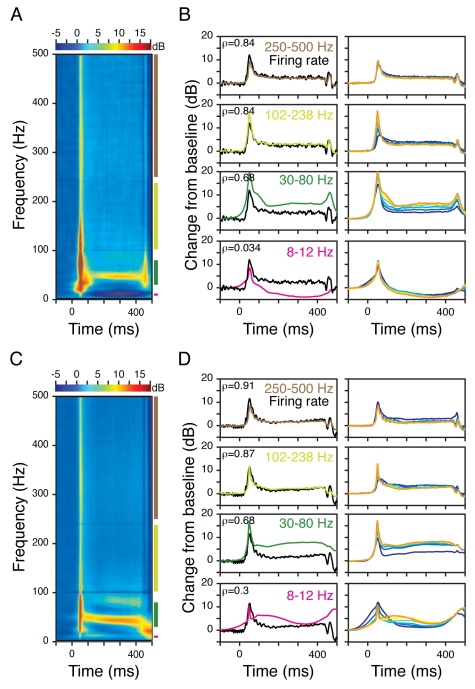
Correlations between the time-courses of firing rate and LFP power in
different frequency bands.(A) The mean time-frequency energy difference plot (in dB) of 15 sites
from Monkey 1, when the largest stimulus is presented. Same as the right
panel of Figure 1E,
except that the displayed frequency range is up to 500 Hz. The vertical
colored lines in the right mark the four frequency bands used for
analysis—alpha (8–12 Hz; magenta), gamma (30–80 Hz;
dark green), high-gamma (102–238 Hz, excluding 118–122 Hz;
light green), and 250–500 Hz (brown). (B) Panels in the left
column show the relative change in LFP power in the four frequency bands
(colored traces) for the largest stimulus, along with the relative
change in firing rate (black trace, same for all panels). The Spearman
rank correlation between the two traces is denoted in the upper-left
corner. Panels in the right show the relative change in LFP power for
different stimulus size (same color code as Figures 1 and 2, the orange trace is the same as
the colored trace in the left column). (C, D) Same as (A, B) for 104
sites in Monkey 2.